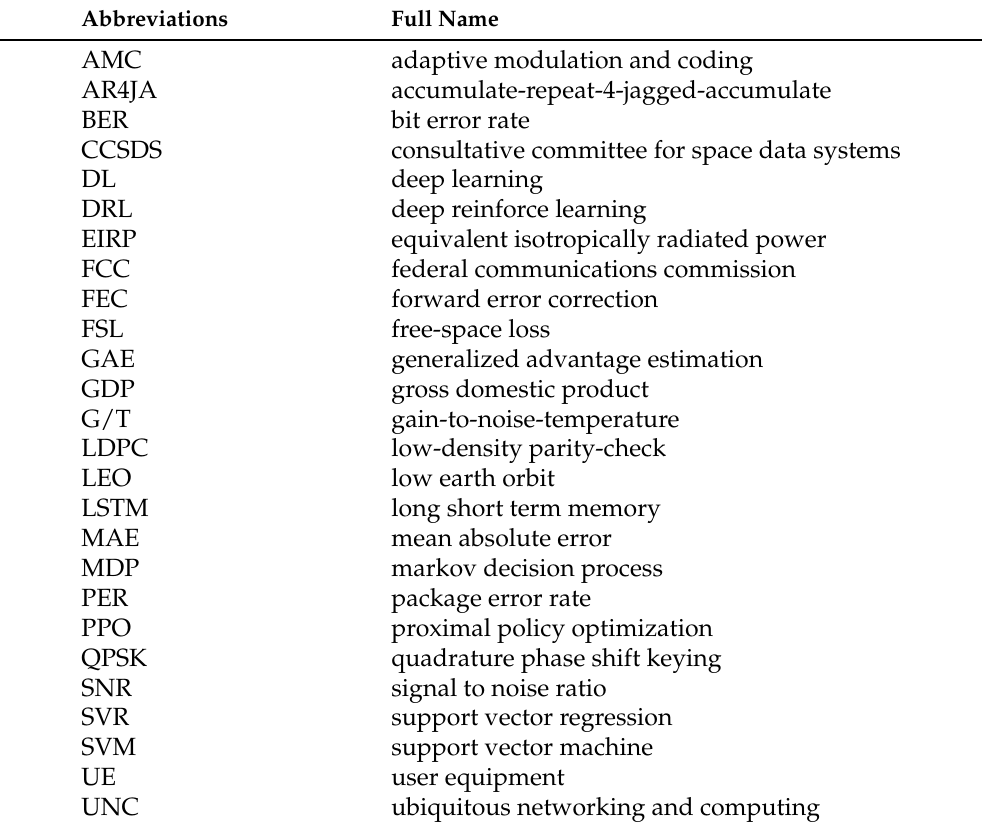
Table 1. Abbreviations in the article